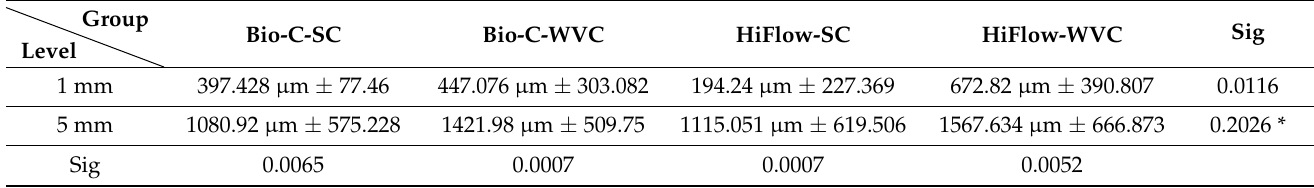
Table 1. Mean penetration depth ( µ m) of two calcium silicate-based sealers.